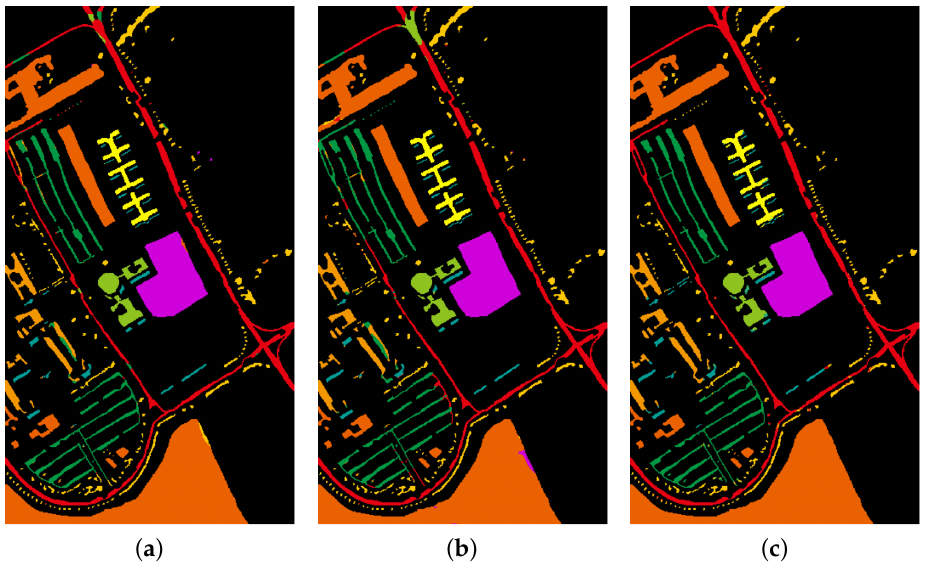
Figure 8. The classification maps of UP. ( a – c ) Classification results of AAE, VAE, and our proposed model,